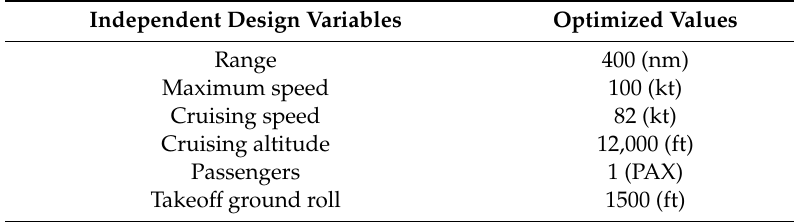
Figure 8. Optimized responses vs. design variables. Table 8. Optimized independent design variables.